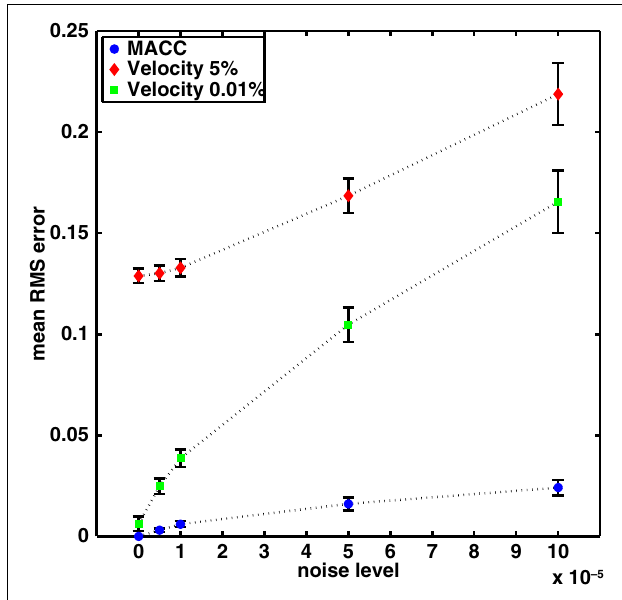
FIGURE 2 | Mean performances of MACC onset and peak velocity methods under four levels of Gaussian noise. Markers and error bars show mean values and mean confi dence intervals, respectively ( p < 0.05). Blue circle: MACC model; Red diamond: 5% peak velocity threshold; Green square: 0.01% peak velocity